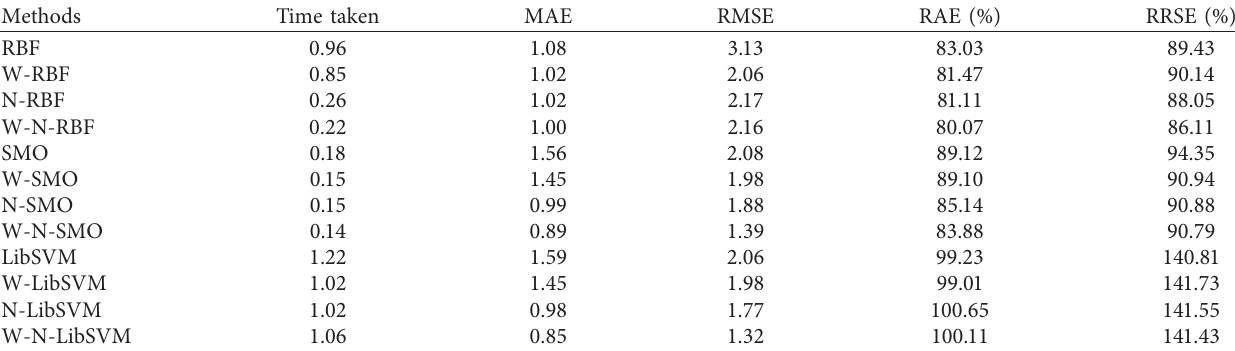
Table 4: Comparison of errors and time taken for wind speed, Delhi.